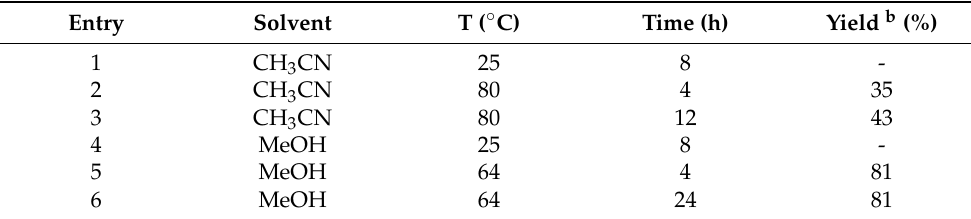
Table 1. Optimization of the reaction conditions a